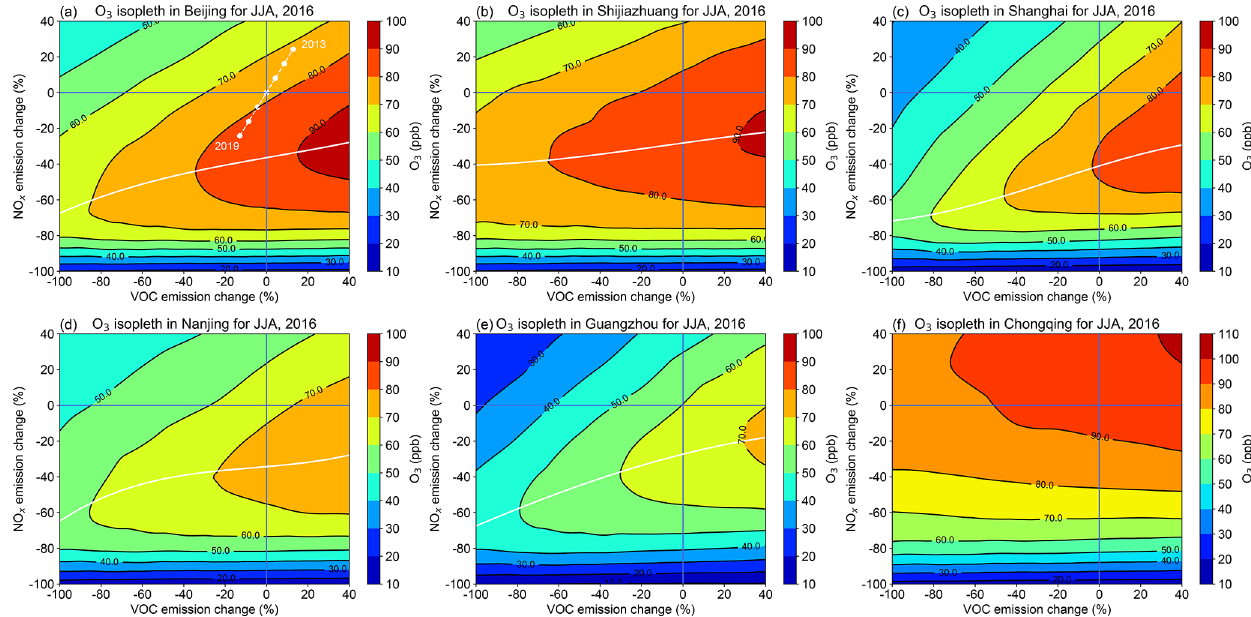
Figure 8. Simulated daytime surface O 3 responses (ppb) to anthropogenic NO x and VOC emission changes for the six industrial regions across China (a–f) in JJA, 2016. The intersection of the vertical and horizontal lines marks current O 3 levels. White ridge lines mark the peak in O 3 concentrations for given VOC emissions and show the approximate transition between VOC-limited (above the ridge) and NO x -limited (below the ridge) regimes. White dots in panel (a) represent simulated daytime O 3 levels in the Beijing region in JJA between 2013 and 2019 following estimated NO x and VOC emission